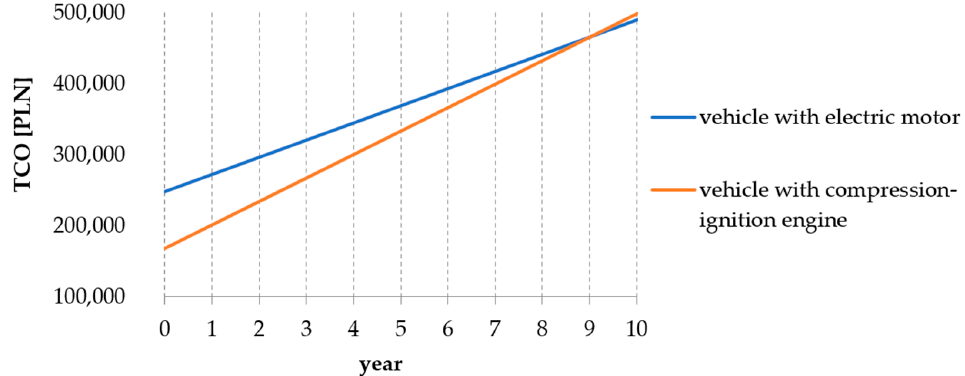
Figure 23. Total cost of ownership of vehicle during the whole operating period—electric vehicle is recharged only at public AC charging stations (the highest price for 1 kWh was included in the calculations—Scenario B3).